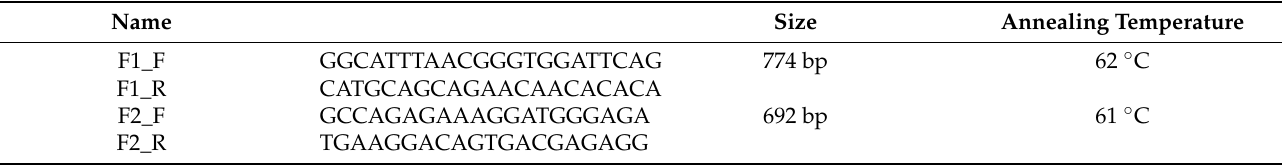
Table 1. Detailed information on specific primer sets used for polymerase chain reaction (PCR).